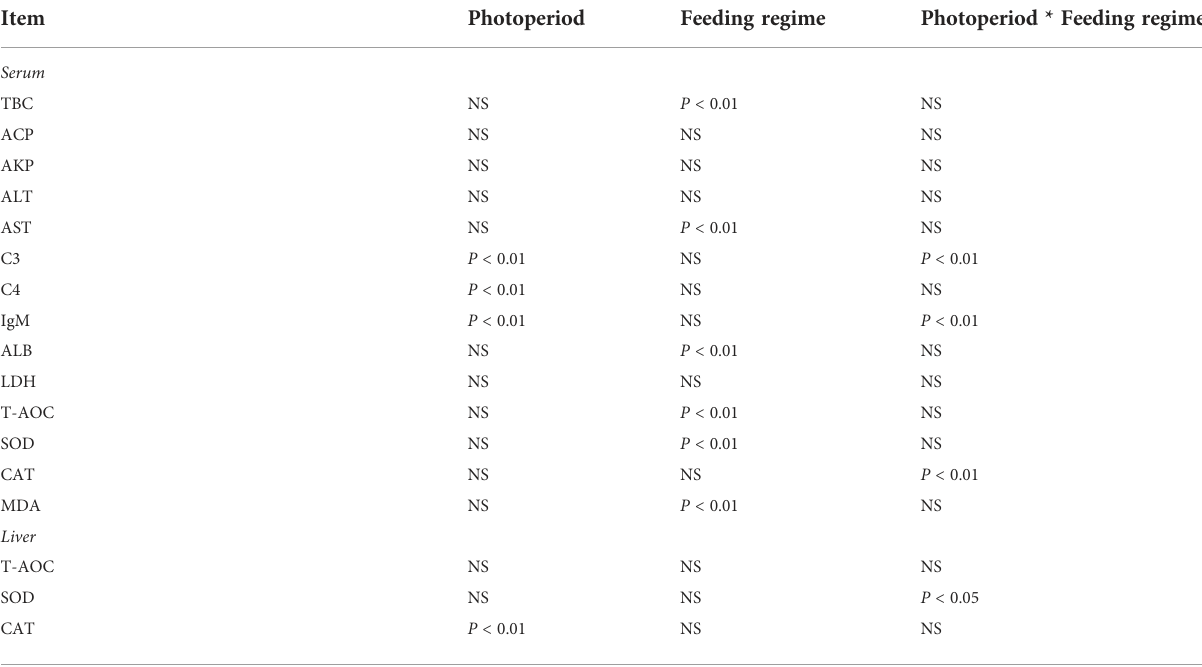
TABLE 2 Summary of two-way ANOVA: Immunity index and gene expression of juvenile Oncorhynchus mykiss under different experimental treatment. Item Photoperiod Feeding regime Photoperiod * Feeding regime